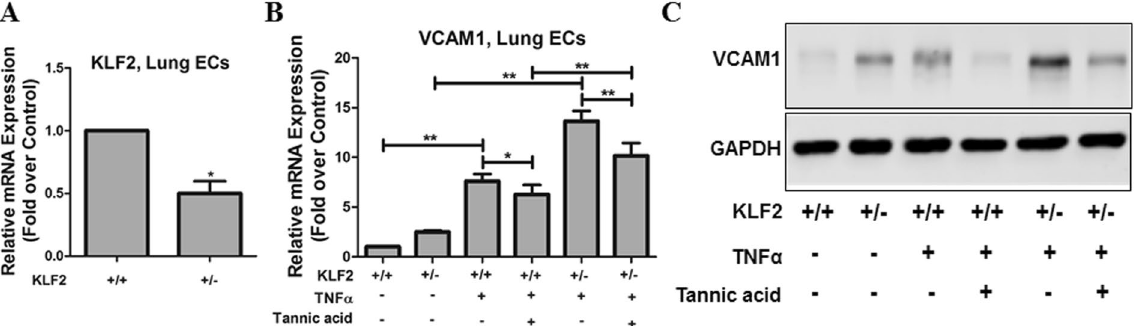
Figure 6. TA inhibited vascular inflammation via KLF2. Mouse lung ECs were isolated from Klf2 + / + or Klf2 + / − mice as described in methods. Pooled lung ECs from 3 mice with identical genotype were included in each group. ( A ) The levels of KLF2 mRNA expression in isolated lung endothelial cells from Klf2 + / + and Klf2 + / − mice were analyzed by qPCR. ( B ) Lung ECs were treated with or without TA for 12 h and stimulated with mouse TNF α for additional 3 h. qPCR was performed to detect VCAM1 mRNA expression. Statistical comparisons and analyses between 2 groups were performed by 2-tailed, paired Student’s t test. * P < 0.05, ** P < 0.01, n = 5. ( C ) Lung ECs were treated with or without TA for 12 h and stimulated with mouse TNF α for additional 6 h. Western blot assays were performed to examine VCAM1 and GAPDH protein